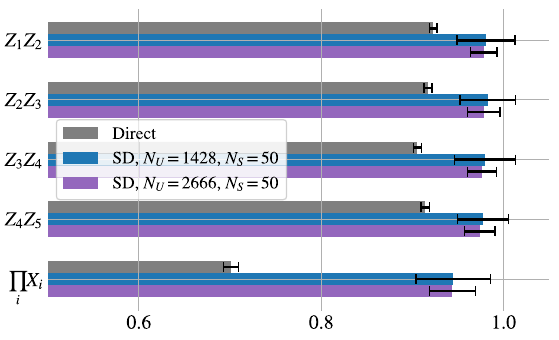
FIG. 3. Contour plot of the simulated error mitigation for the FIG. 4. We compare the experimental results of directly mea- GHZ state for varying N S and N U . The color bar indicates the sured expectation values tr (ρ O ) using N S = 2000 with mitigated logarithm of the mean squared error (cid:5) 2 . The dashed lines values (cid:3) O (cid:2) 2 using N U = 1428, 2666 and N S = 50 measurements. GHZ = indicate the contours obtained from the empirical fit (cid:5) 2 The labels on the y axis indicate the choices for O and the x axis GHZ )( 1 + 22 / N 2 ) . The red lines show the contours of fixed ( 3384 / N 2 shows the expectation value. Increasing N U reduces the error on U S T = N U ( 1000 + N S ) for T = 1.5 × 10 7 and T = 2.8 × 10 7 , with the estimate. Error bars are standard deviations obtained from the circles indicating the optimal choices of N U and N S . In the bootstrap sampling in SD and from normal approximation in the > 0.1. white region of the plot (cid:5) 2 direct GHZ